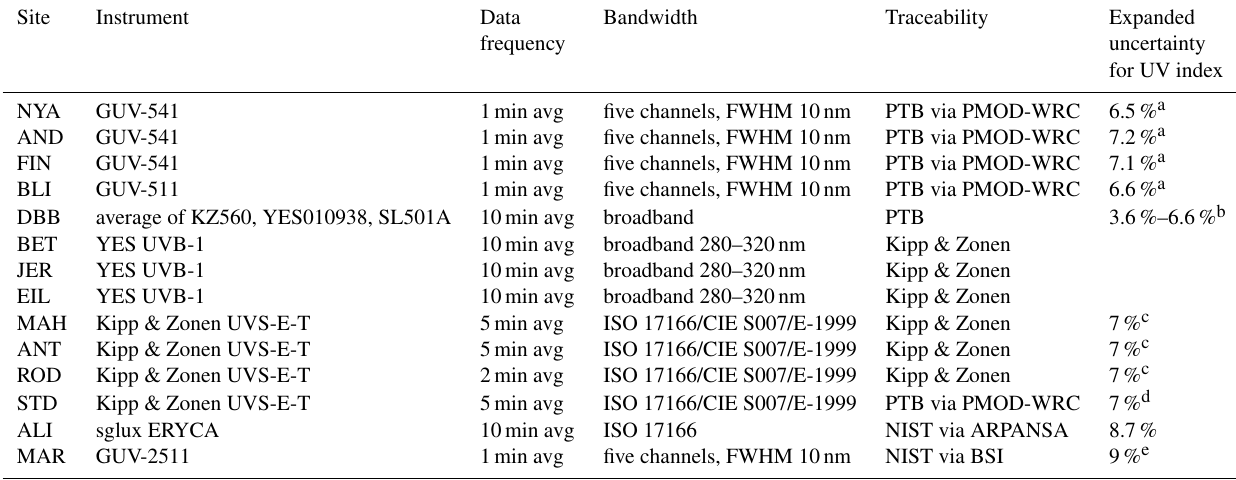
Table 4. Broadband and multiband radiometers used in the study and their characteristics. Data period is from 1 January 2018 to 31 August 2019. The erythemal action spectrum used for retrieving erythemally weighted dose rates and daily doses is Commission Internationale de l’Eclairage (1998) for all other instruments except for BET, JER, EIL and MAR, for which it is McKinlay and Diffey (1987). If no publication is linked to the uncertainty, the expanded uncertainty is an estimation calculated by the operator of the instrument. See Table 2 for explanation of site